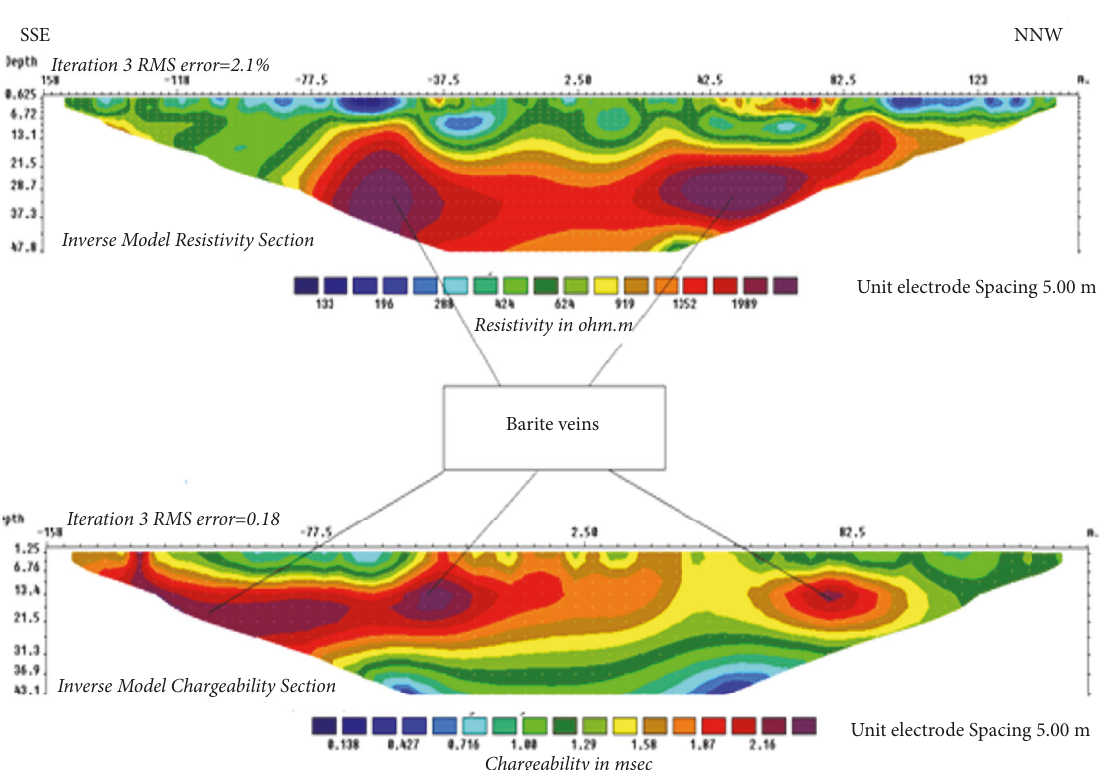
Figure 9: Inverse model resistivity and chargeability sections (Taroucht 2; direction: SSE-NNW).